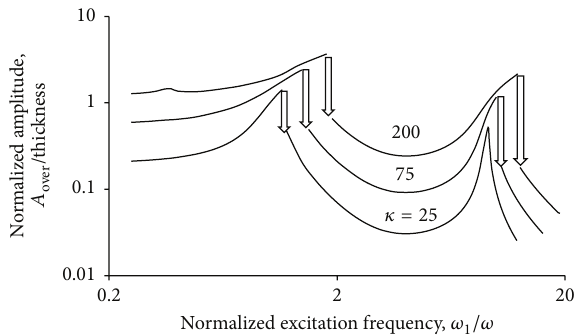
Figure 2: Frequency-amplitude curve for various excitation levels. Table 2: (a) Modal contributions for various excitation frequencies, 𝜔 = 1.5𝜔 1 . (b) Modal contributions for various excitation frequen- cies, 𝜅 = 7.5